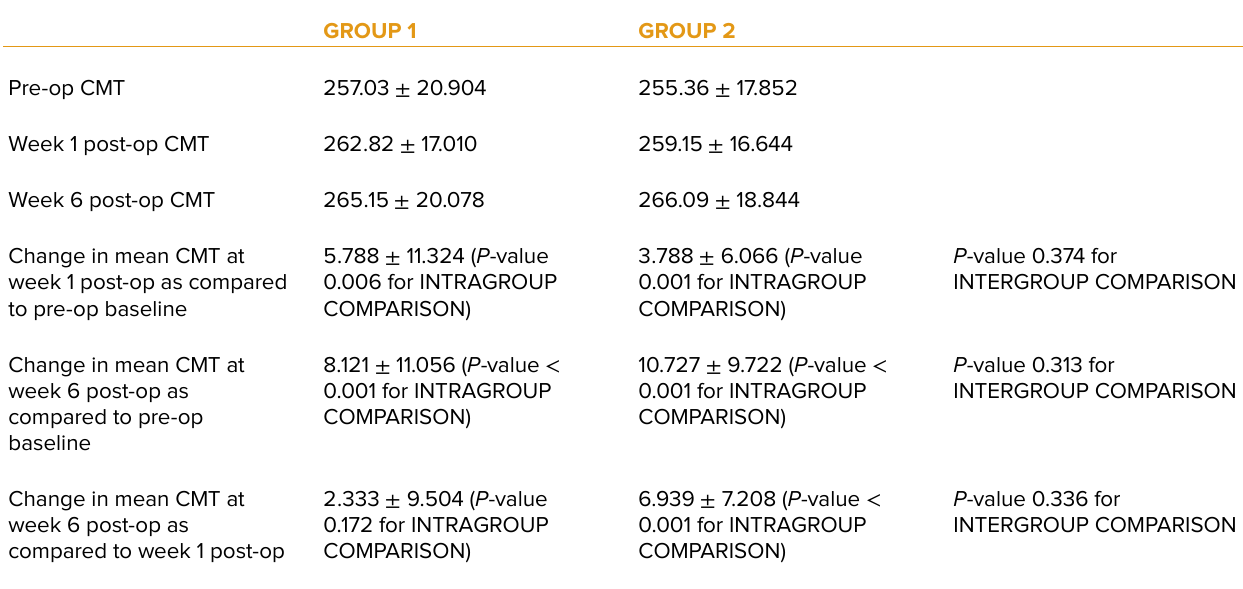
Table 2. Groups 1 and 2: Repeated measure analysis and multiple comparison correction with Bonferroni method depicting change in mean central macular thickness from baseline to postoperative week 1 and week